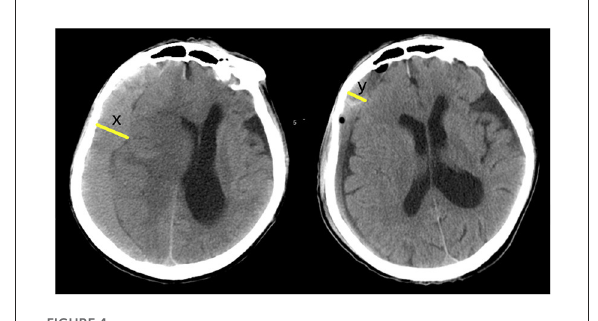
FIGURE4 Post-operative BNER: x = maximum width of pre-operative hematoma; y = maximum width of residual hematoma at a certain time point after operation (3 days or a week, or a month after surgery). BNER = y ÷ x. The greater the value, the worse the degree of brain